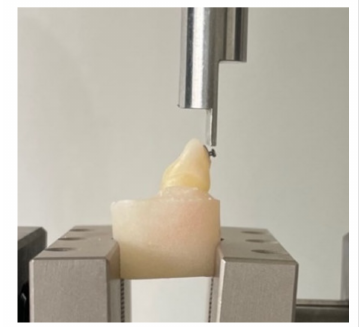
Figure 1. Bracket debonding procedure using Loyd Universal Testing